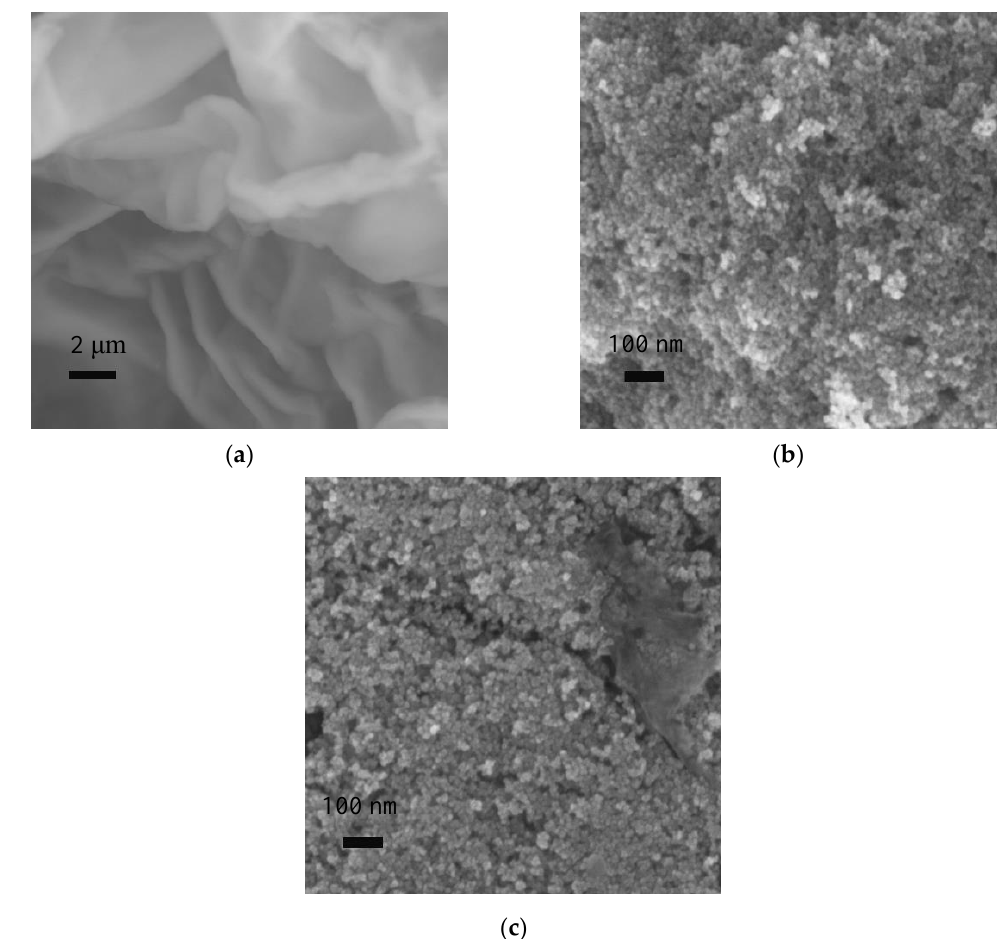
Figure 1. ( a ) SEM image of GO; ( b ) SEM image of Fe 3 O 4 ; ( c ) SEM image of Fe 3 O 4 –rGO.